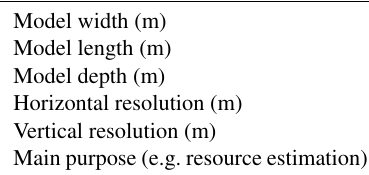
Table A2. Model dimensions and